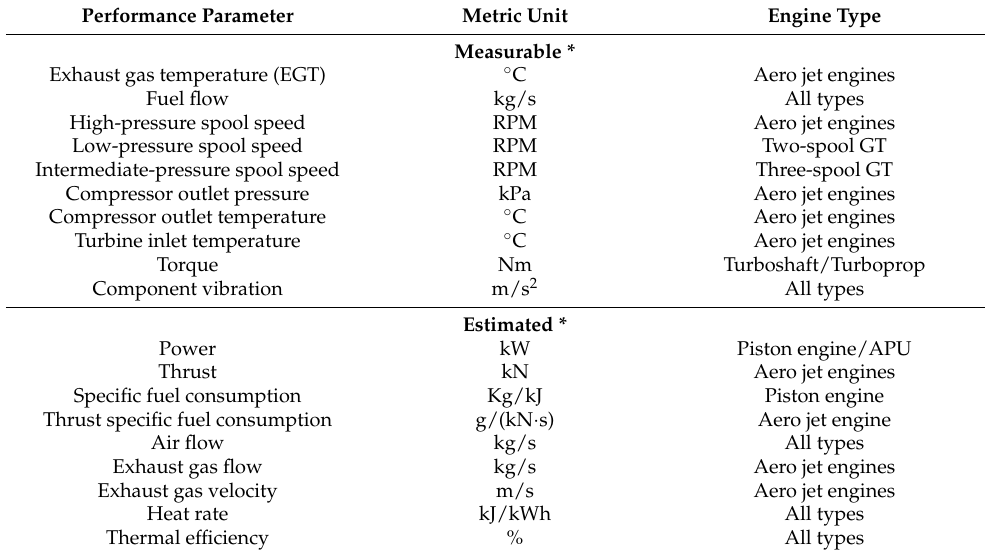
Table 2. Commonly used PPs for aeroengines